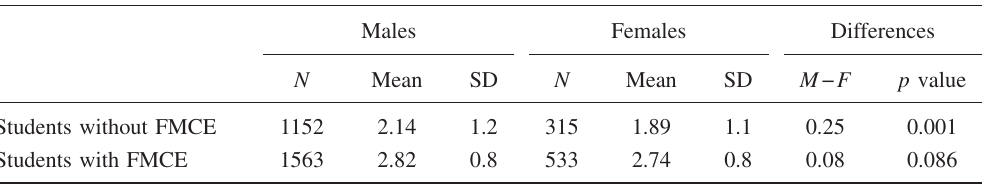
TABLE II. Average course grades for males and females who did and did not take the FMCE. Course grades are on a 0–4.0 scale (cid:1) Ref. 34 (cid:2) .